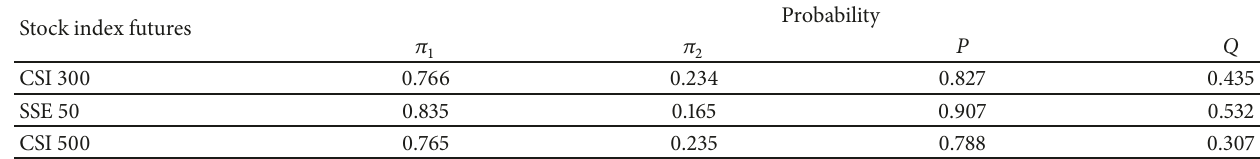
Table 5: The steady-state probability and state transition probability of basis sequences for stock index